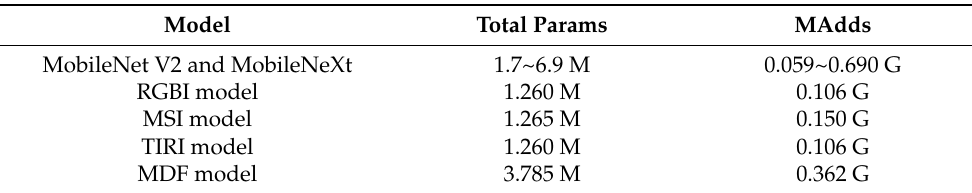
Table 7. Total number of network parameters (Total params) and theoretical amount of multiply-adds (MAdds) of